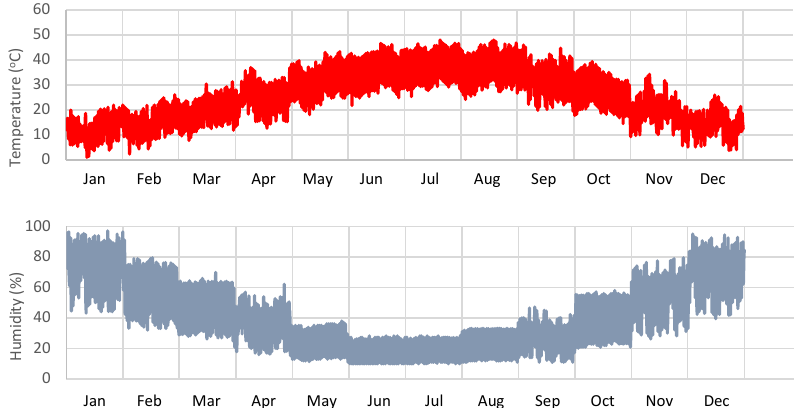
Figure 1. Annual temperature and relative humidity profiles for Kuwait [12].